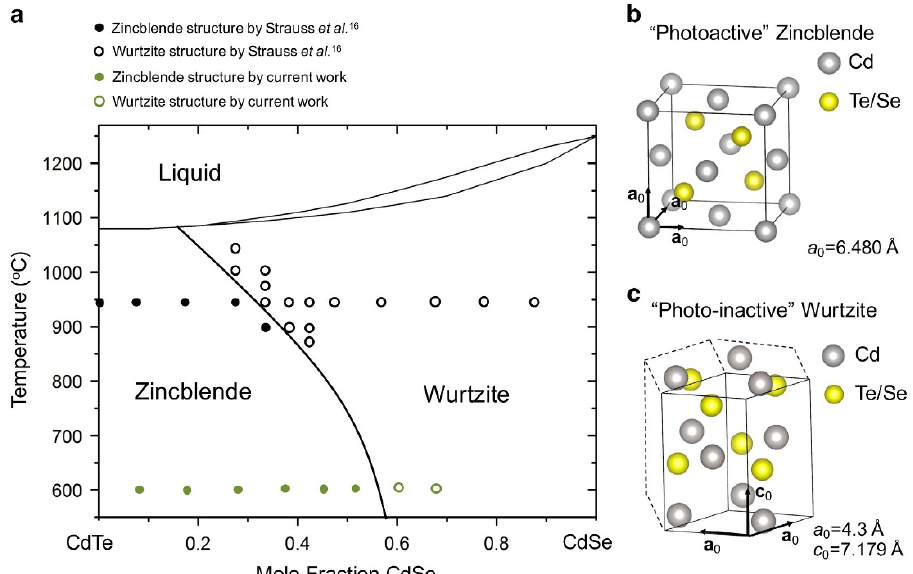
Figure 6 | Phase diagram of the CdTe-CdSe pseudobinary system. ( a ) An updated phase diagram for the CdSe-CdTe pseudobinary system using data from Strauss et al. 16 and the APT and TEM-SAD results from the present studies. ( b ) Schematic of the unit cell of the photoactive zincblende structure. ( c ) Schematic of the unit cell of the photoinactive wurtzite